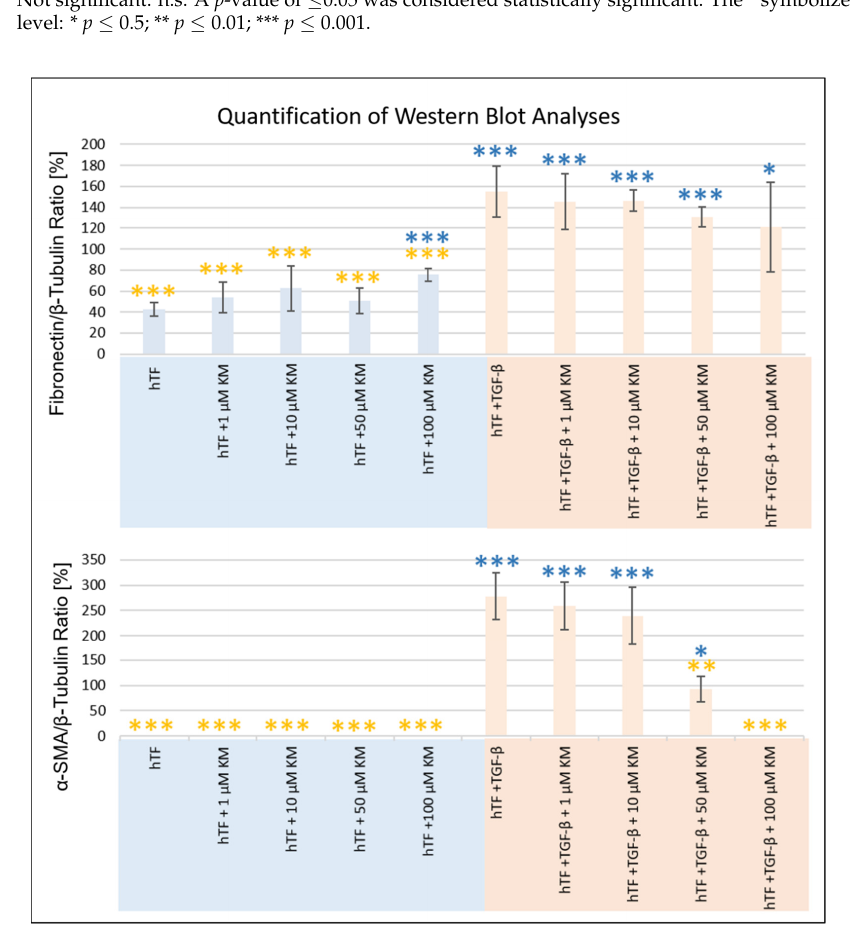
Figure 4. Quantification of Western blot analyses for the in vitro evaluation of the antifibrotic effect of kitasamycin (KM) in a TGF ‐β 1 ‐ mediated fibrotic cell culture model. Quantification of data from Western blot analysis of human Tenon’s fibroblast (hTF) cell lysates under different culture condi ‐ tions (Figure 3) for fibronectin and α‐ SMA. Each column represents a mean ± SD of three experi ‐ ments. In each case, the values were normalized to the loading control β‐ tubulin. Statistical analysis was performed using a t ‐ test. The blue asterisk * symbolizes the significance of each approach com ‐ pared with untreated fibroblasts (hTFs). The orange asterisk * symbolizes the significance of the individual approaches compared with myofibroblasts (hTFs + TGF ‐β 1). A p ‐ value of ≤ 0.05 was con ‐ sidered statistically significant. Significance levels: * p ≤ 0.5; ** p ≤ 0.01; *** p ≤ 0.001.